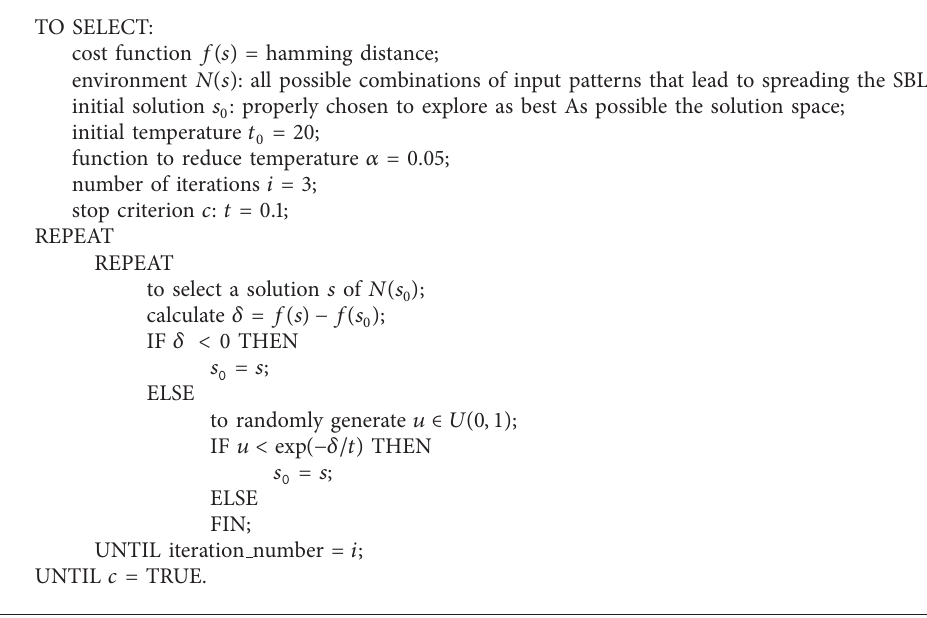
Algorithm 1: Scheme for simulated annealing